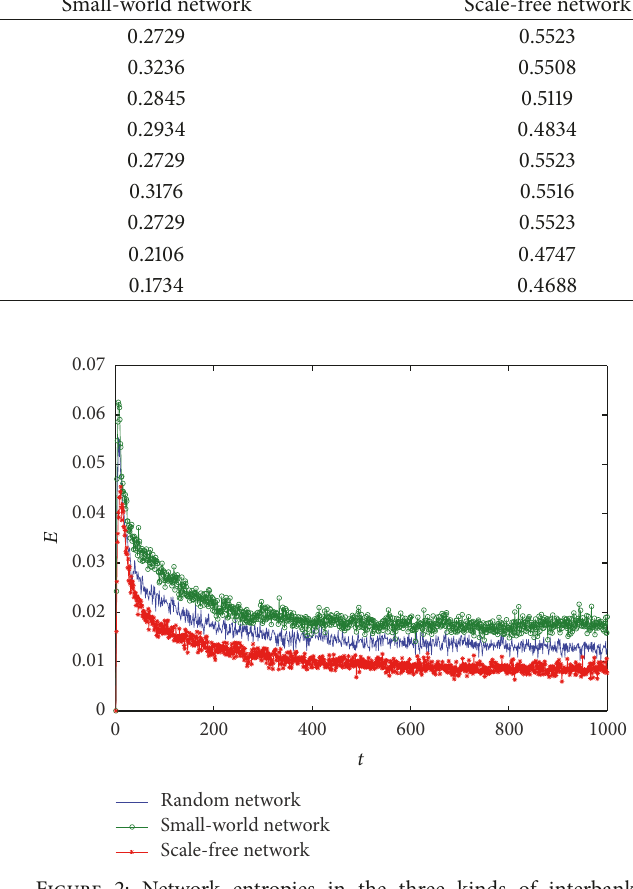
Figure 2: Network entropies in the three kinds of interbank